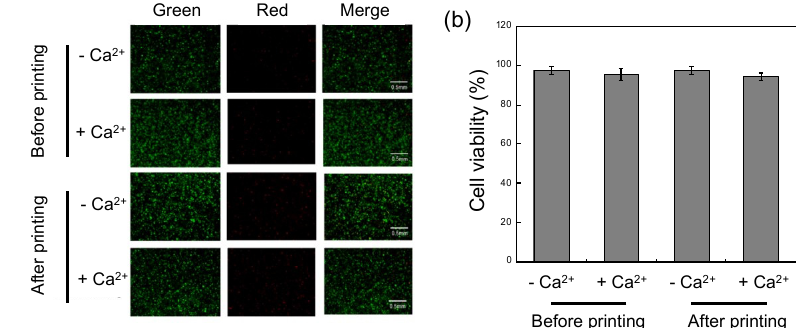
Figure 6. ( a ) Images of live and dead cells encapsulated within OHA/GC/ADH/ALG hydrogels be- fore and after printing process. Secondary cross-linking of the gels was carried out with calcium ions (+Ca 2+ ), and non-cross-linked gels were also used ( − Ca 2+ ). ( b ) Quantitative results from live/dead assays.